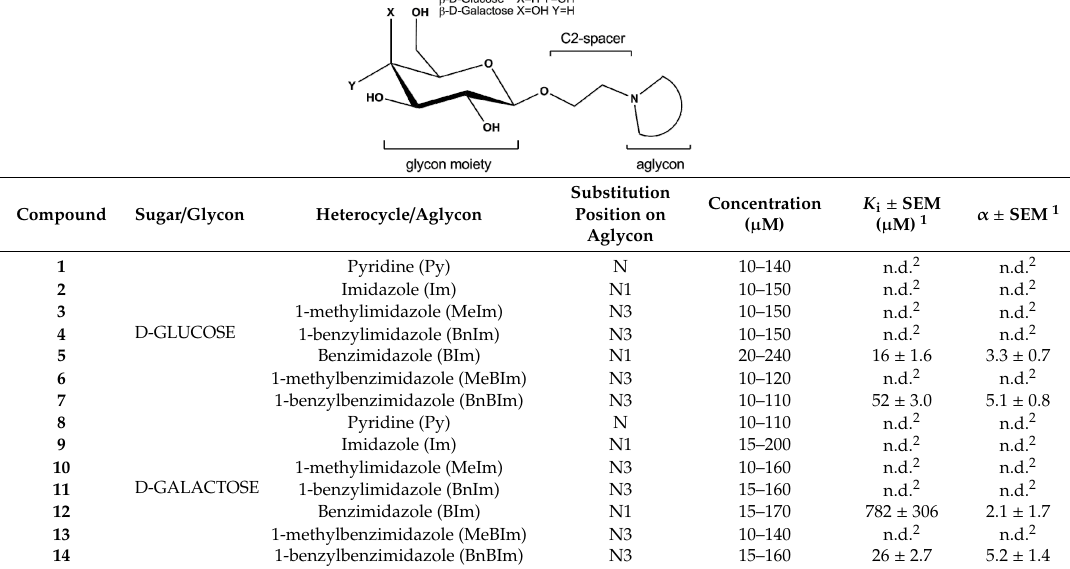
Table 1. Prepared heterocyclic β - D -glycoconjugates 1 – 14 and inhibition potency toward horse serum BChE.